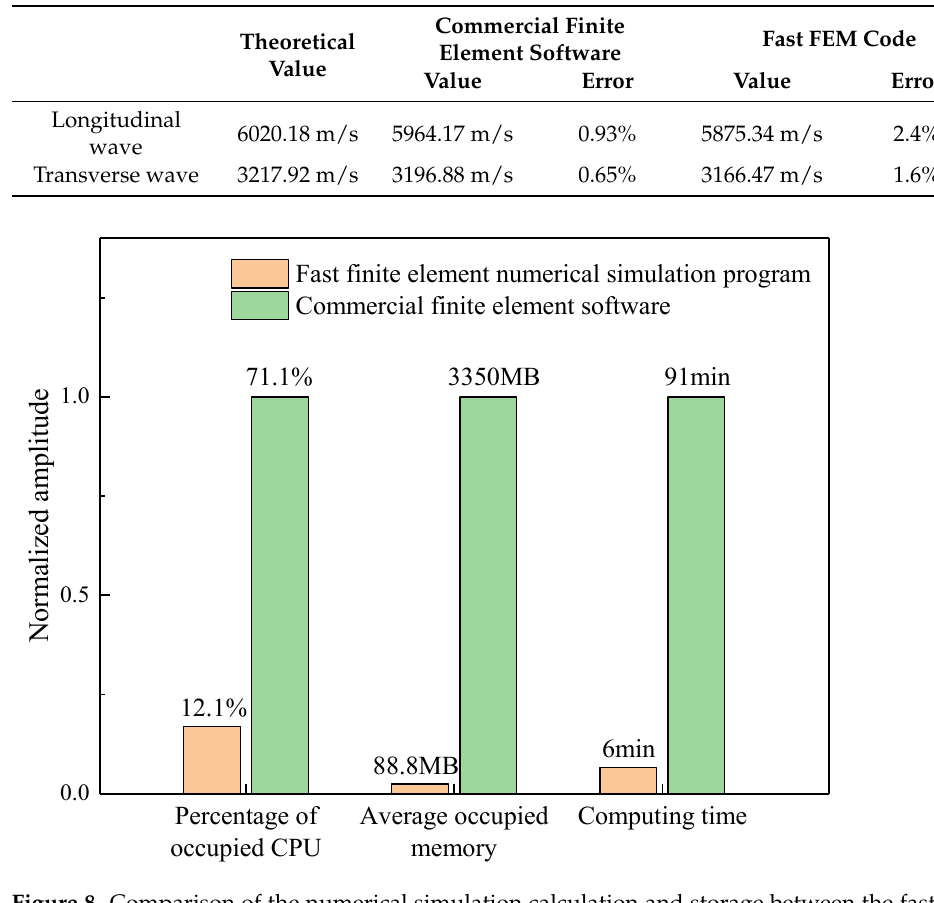
Table 3. Comparison of the results of the ultrasonic wave velocity using the different methods.